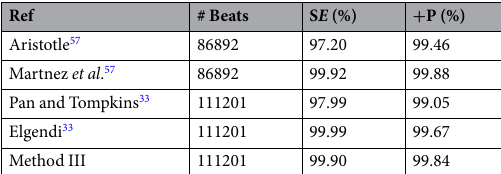
Table 6. Comparison of the QRS detection with other published algorithms on the QT database. SE stands for sensitivity, while + P stands for positive